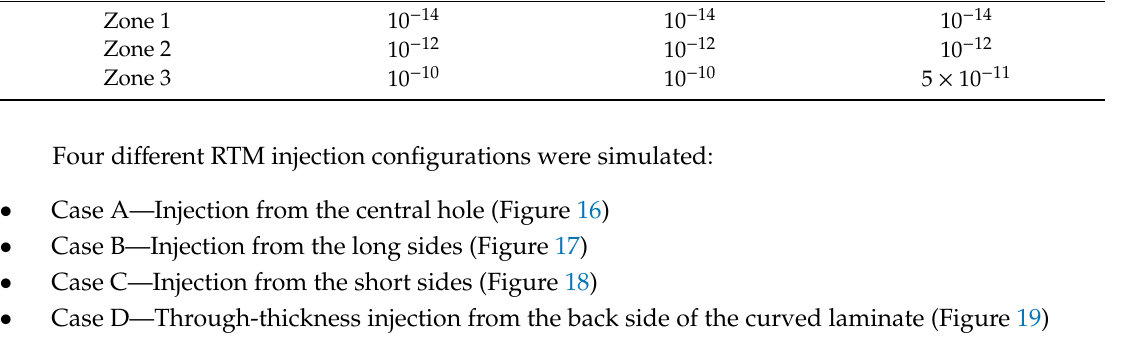
Figure 16. Injection case A for the fuselage section.